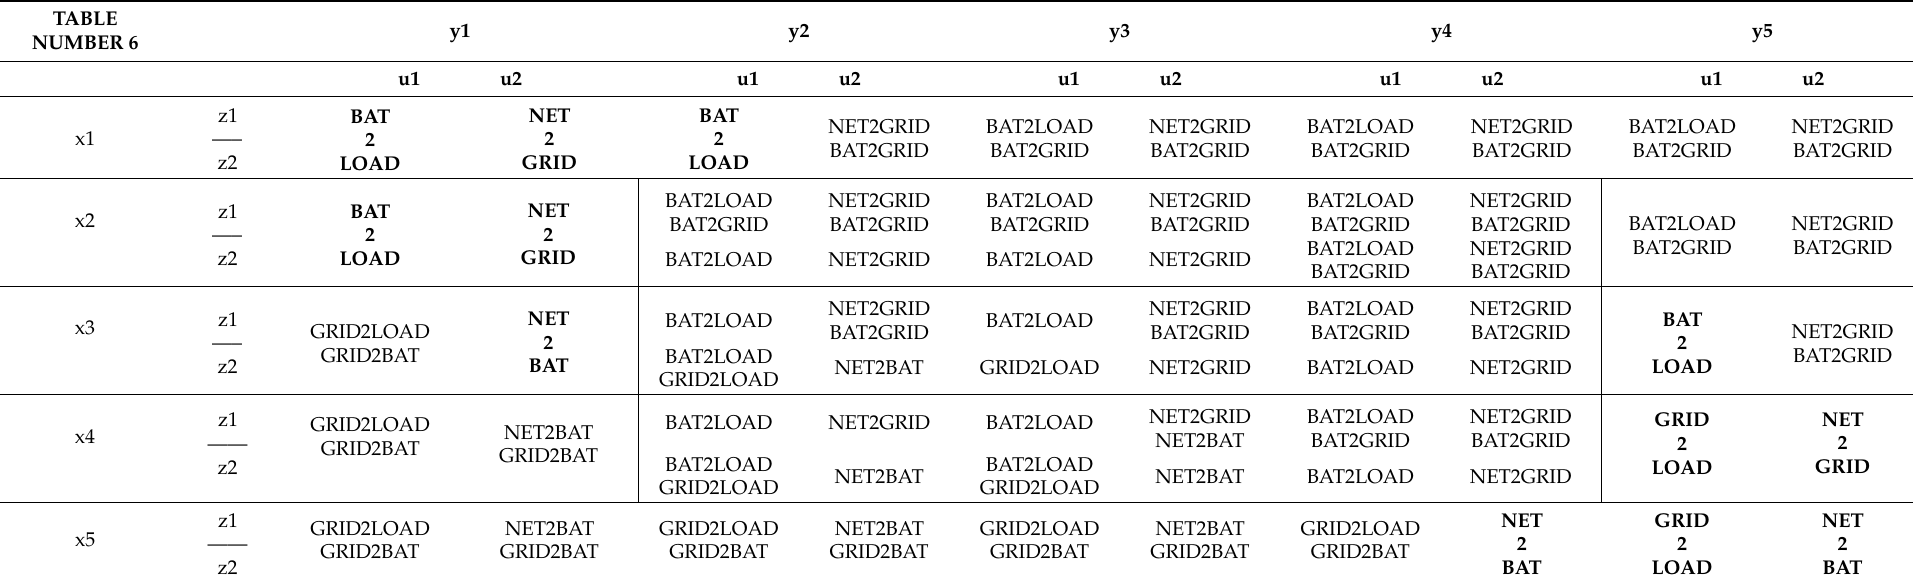
Table 6. Table 3 with the notation of the rule-based expert system